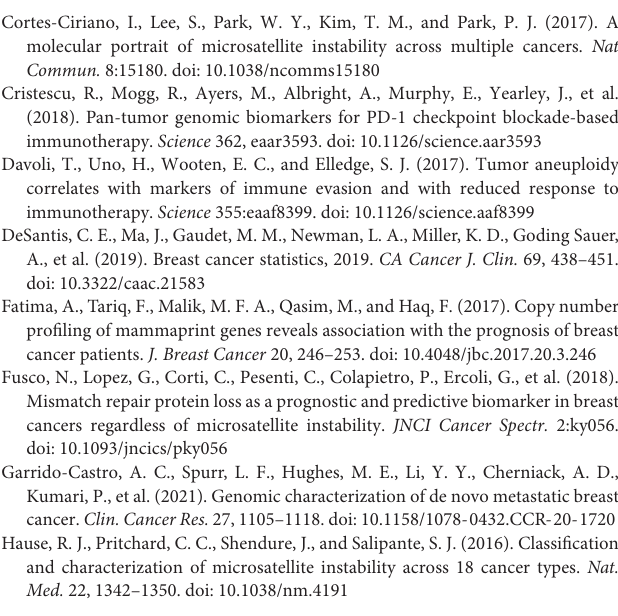
Supplementary Table 3 | The univariate Cox results of 130 DEGs. Supplementary Table 4 | The coefficients of 11 genes involved in